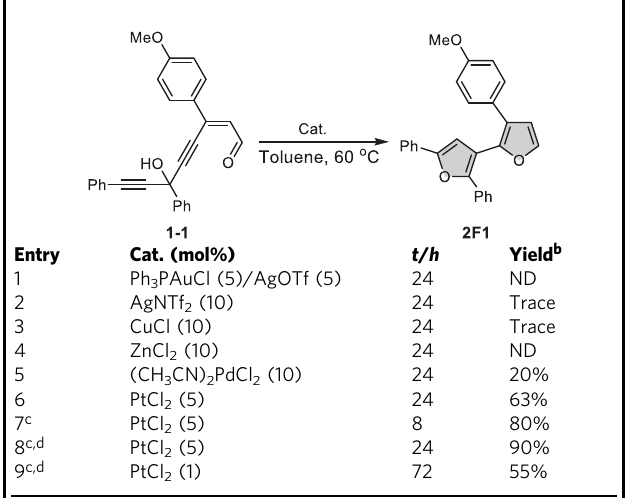
Table 1 Optimization of the reaction conditions a